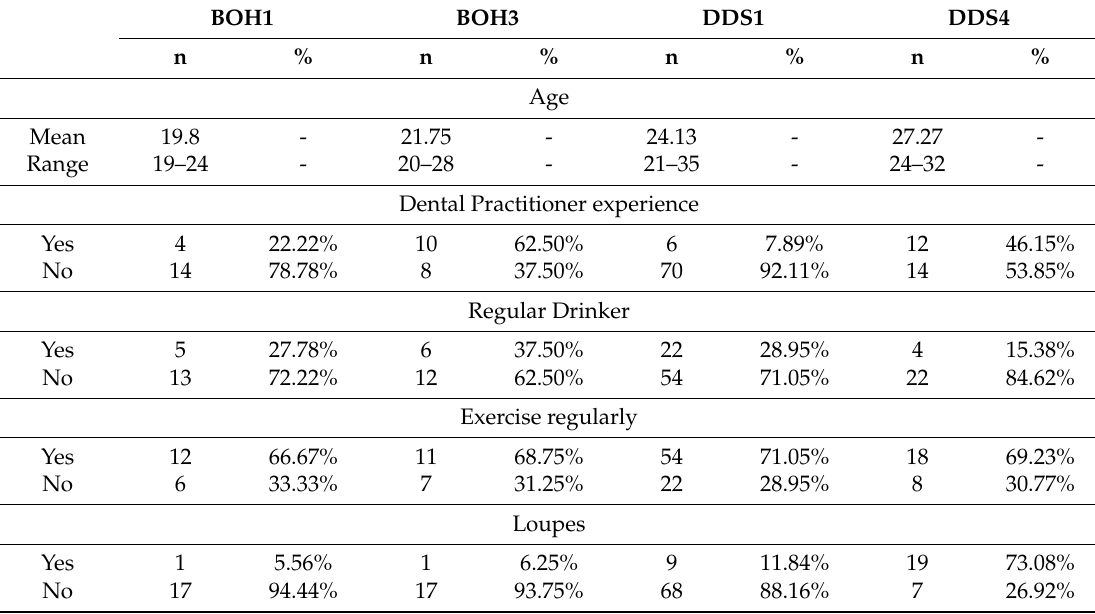
Table 3. Demographic data of MSD survey